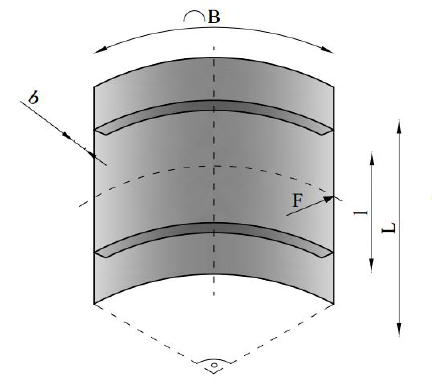
Figure 5. Stiffened fuselage section problem: geometry and notation.